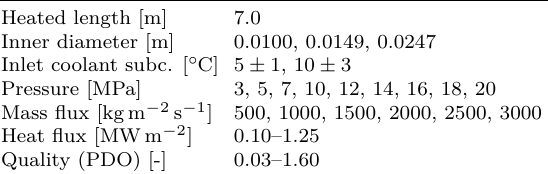
Table 2. Range of experimental parameters and geometry.